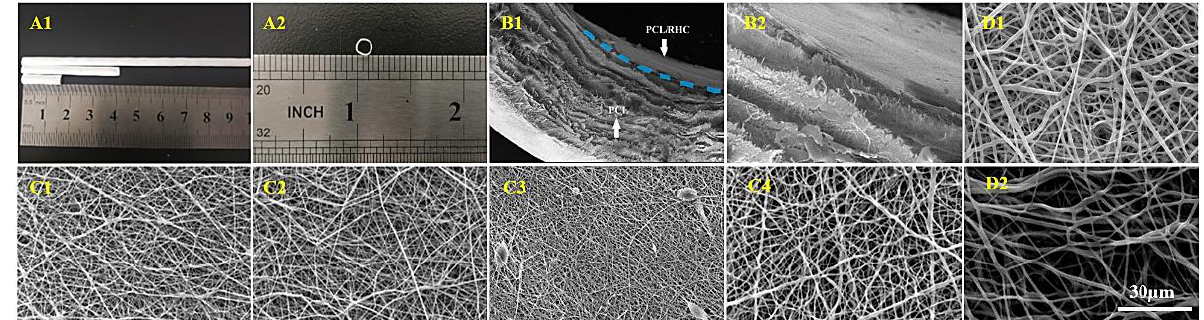
Figure 3. Digital images of scaffolds in the transverse ( A1 ) and cross-section ( A2 ). SEM images of a cross-section of the bilayer scaffold ( B1 ) and a higher magnification image of the interface between both layers ( B2 ). SEM images of electrospun internal layers (PCL/RHC) with different ratios: ( C1 ) (2:1), ( C2 ) (1:1), ( C3 ) (1:2), and ( C4 ) (1:0), as well as the outer layer (PCL/PEO) ( D1 ), before washing out PEO and ( D2 ): after washing out PEO. Table 1. Fiber diameter, porosity, and pore area of different electrospun membranes. PCL/RHC PCL/PEO Non-Washing Washing Out BS1 BS2 BS3 BS4 Out PEO